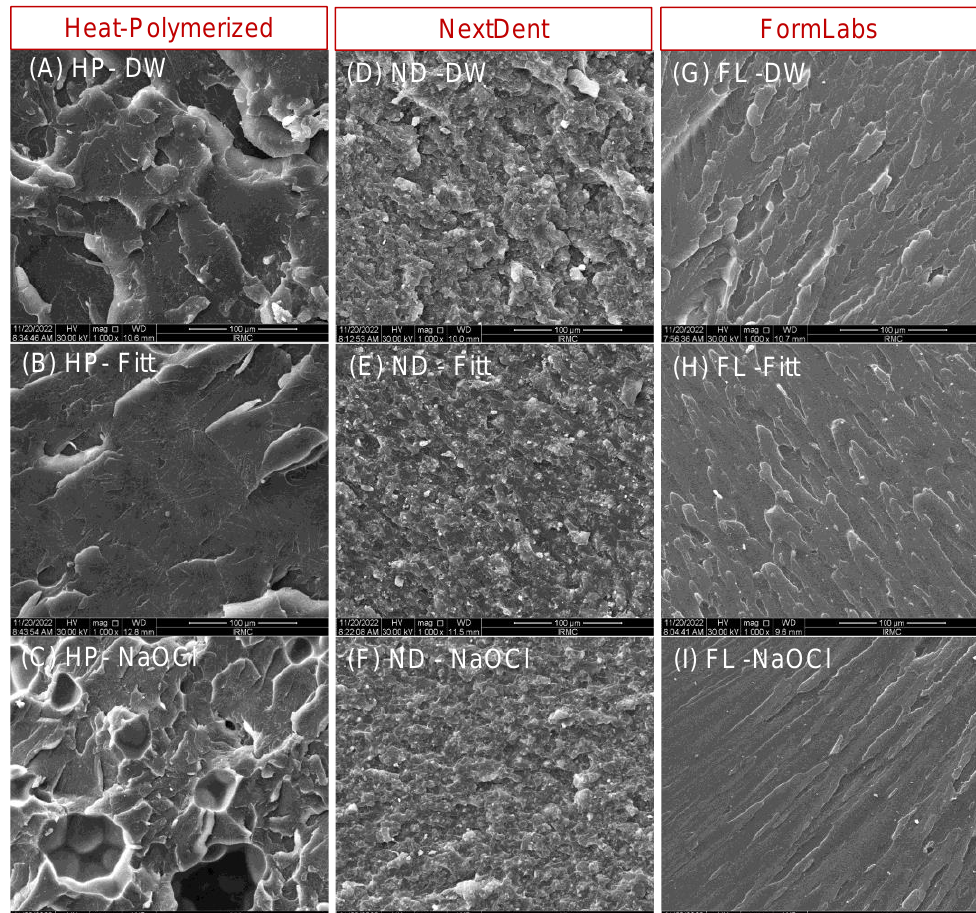
Figure 2. Representative SEM images of the three fractured materials (HP resin, ND, and FL) disinfected with the three solutions (DW, Fitt, and NaOCl). ( A ) HP – DW, ( B ) HP – Fitt, ( C ) HP – NaOCl, ( D ) ND – DW, ( E ) ND – Fitt, ( F ) ND – NaOCl, ( G ) FL – DW, ( H ) FL – Fitt, and ( I ) FL – NaOCl. SEM magnifica-